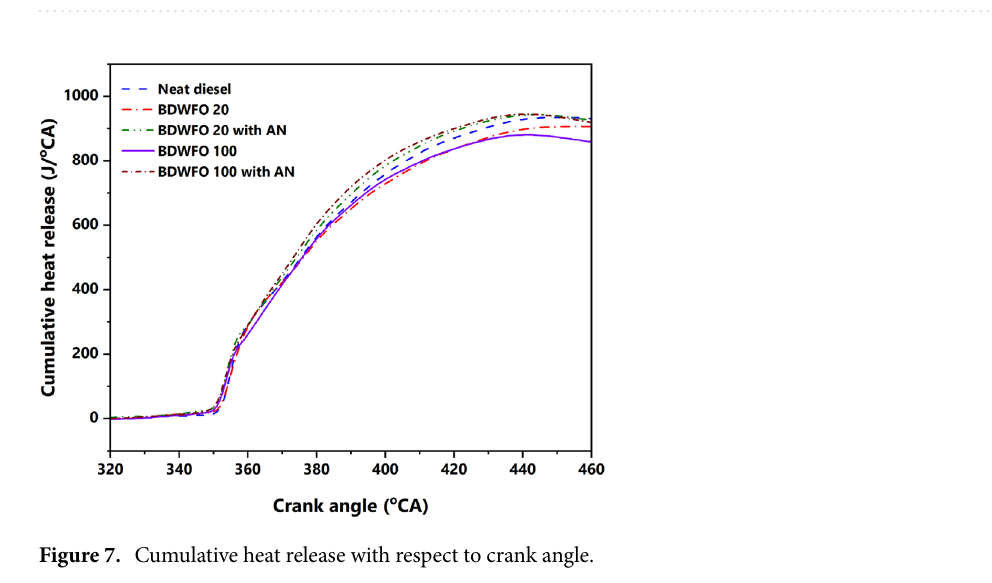
Figure 6. Heat release rate—HRR variations related to the crank angle (CA).